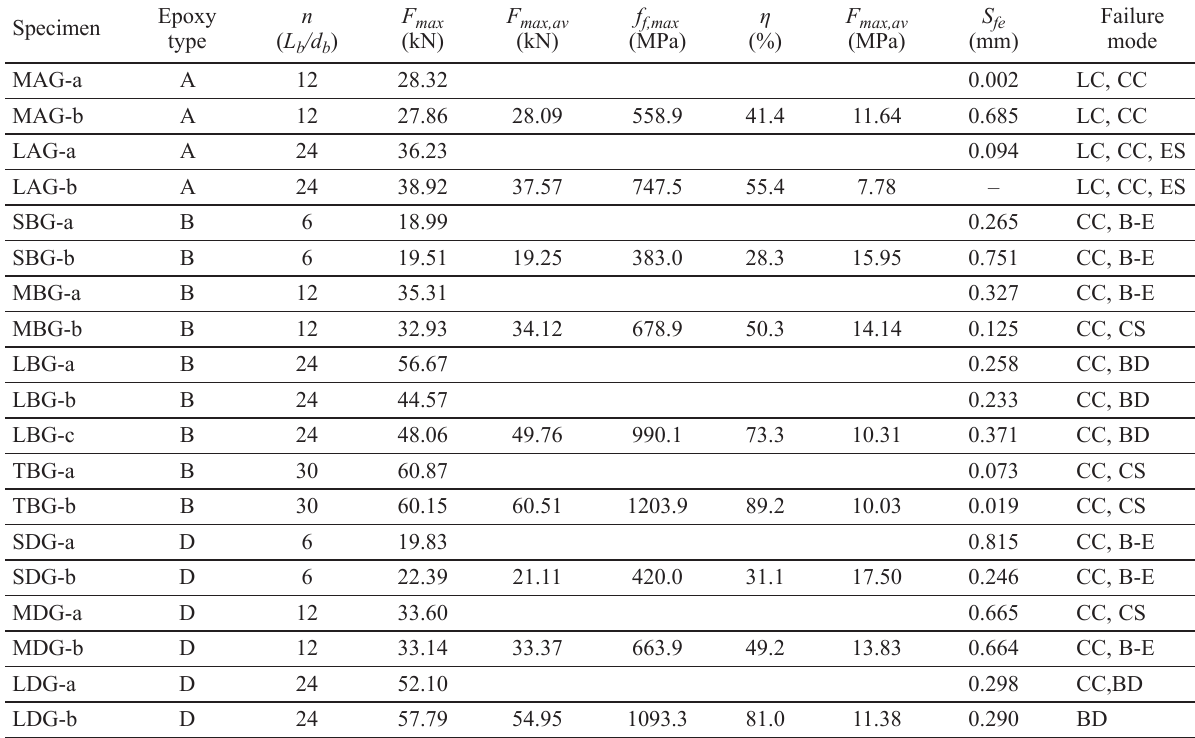
Table 3. Test results for specimens with GFRP bars Specimen